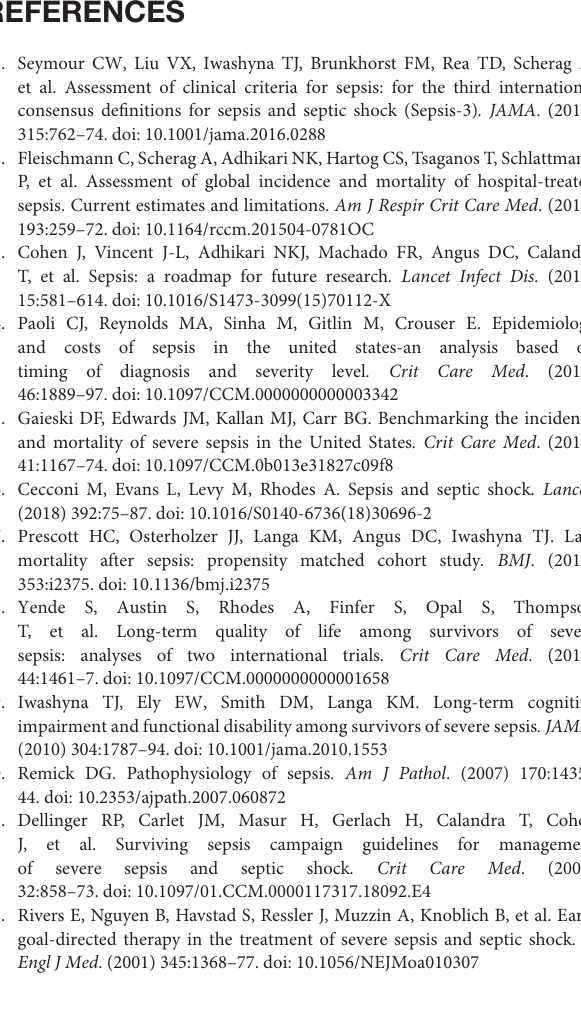
done by independent student’s t -test. Supplementary Figure 2 | (A) Quantitative PCR analysis of spleen IL-6, IL-1 β , TNF- α in different dose of Decitabine treated mice. (B) Effects of Decitabine on CLP lung morphology. The mice were sacrificed 6h after operation and lung tissue was stained with haematoxylin-eosin (magnification, × 400). (C) The lung injury score. n = 5. Data were shown in Mean ± SD. ∗∗∗∗ p < 0.0001, ∗∗∗ p < 0.001, ∗∗ p < 0.01, ∗ p < 0.05. Comparisons between two groups were done by independent student’s t -test. Supplementary Figure 3 | (A) Location of cytokine antibody spotted onto the membrane. (B) Relative expression of 12 cytokines in mice spleen lysate n = 3. Data were shown in Mean ± SD. Supplementary Figure 4 | Kyoto Encyclopedia of Genes and Genomes (KEGG) enrichment analysis of methylation variable positions ( p < 0.05). Supplementary Figure 5 | (A) Representative western blot for p-JNK, JNK, p-MST1/2, MST2, p-AKT, AKT, p-P38, P38, p-EGFR, EGFR, VEGFR2, and β -Actin in sepsis mice spleen with or without Decitabine treatment. (B–G) The bands were quantified by densitometry and normalized to the density of corresponding total protein or β -actin n = 3.Data were shown in Mean ± SD. ∗∗∗∗ p < 0.0001. Comparisons between two groups were done by independent student’s t